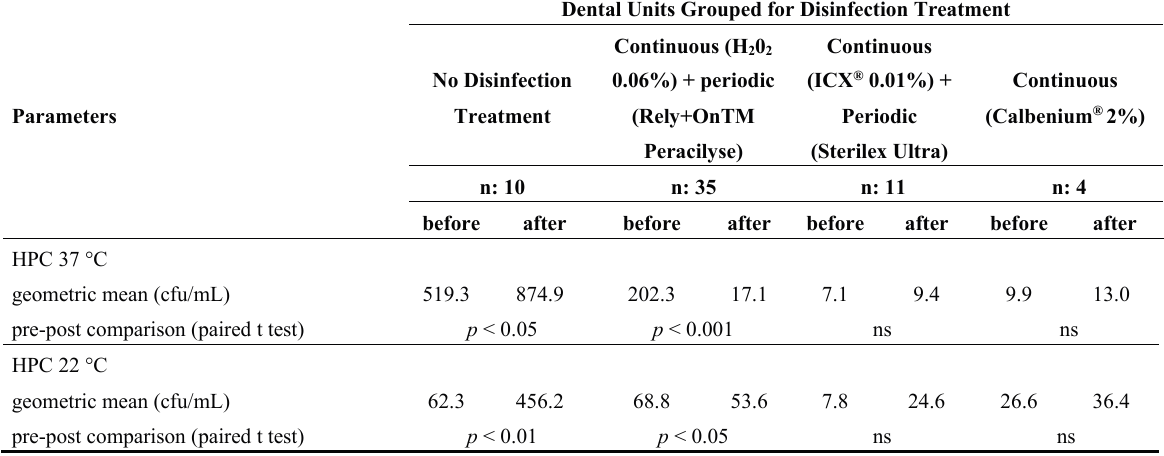
Table 6. Comparison of the bacterial contamination of output water from dental units before and after implementation of the risk management